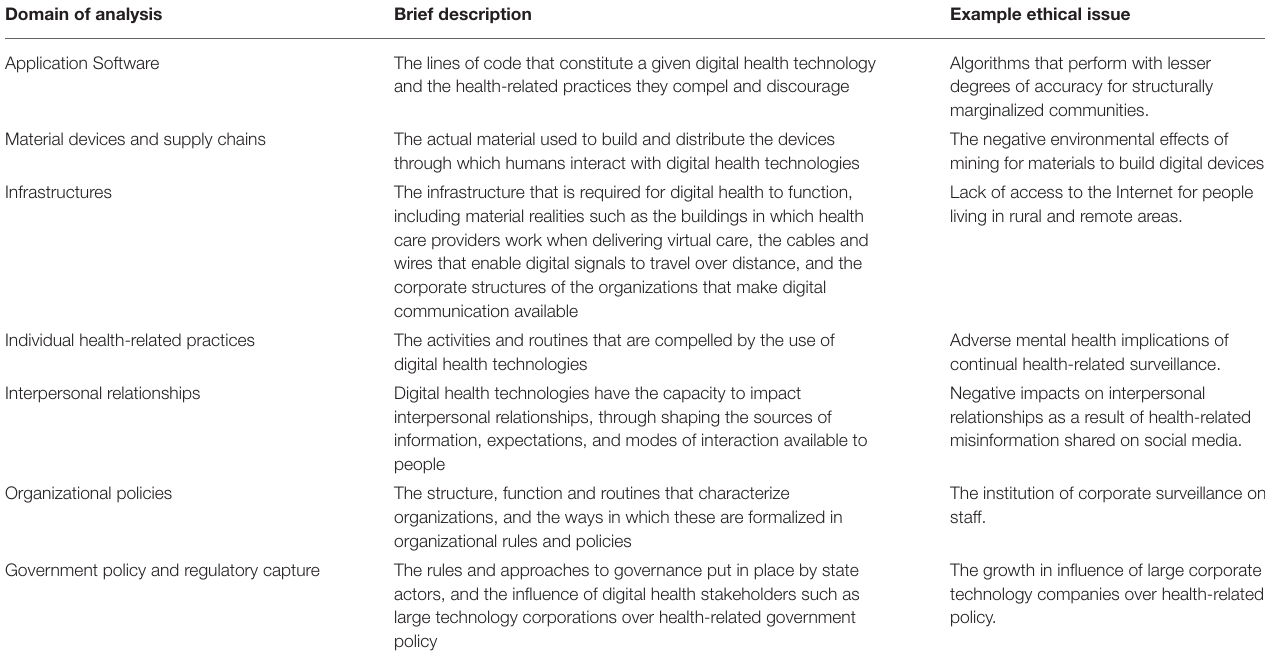
TABLE 1 | Domains of analysis in a sociotechnical approach to digital health